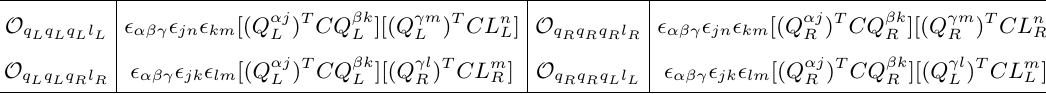
2 = 8] class of operators. Each operator has (cid:2)